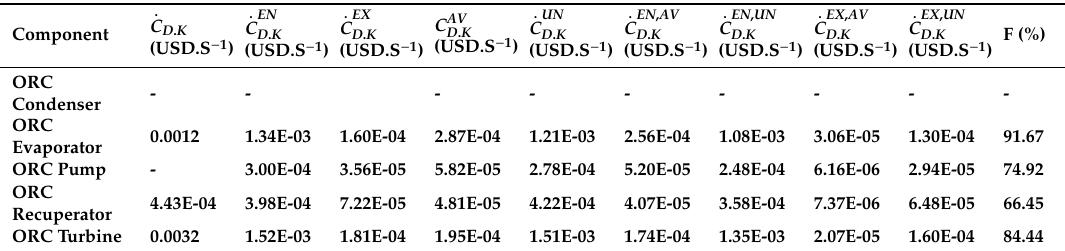
Table 15. Advanced exergo-economic analysis for the standalone geothermal cycle